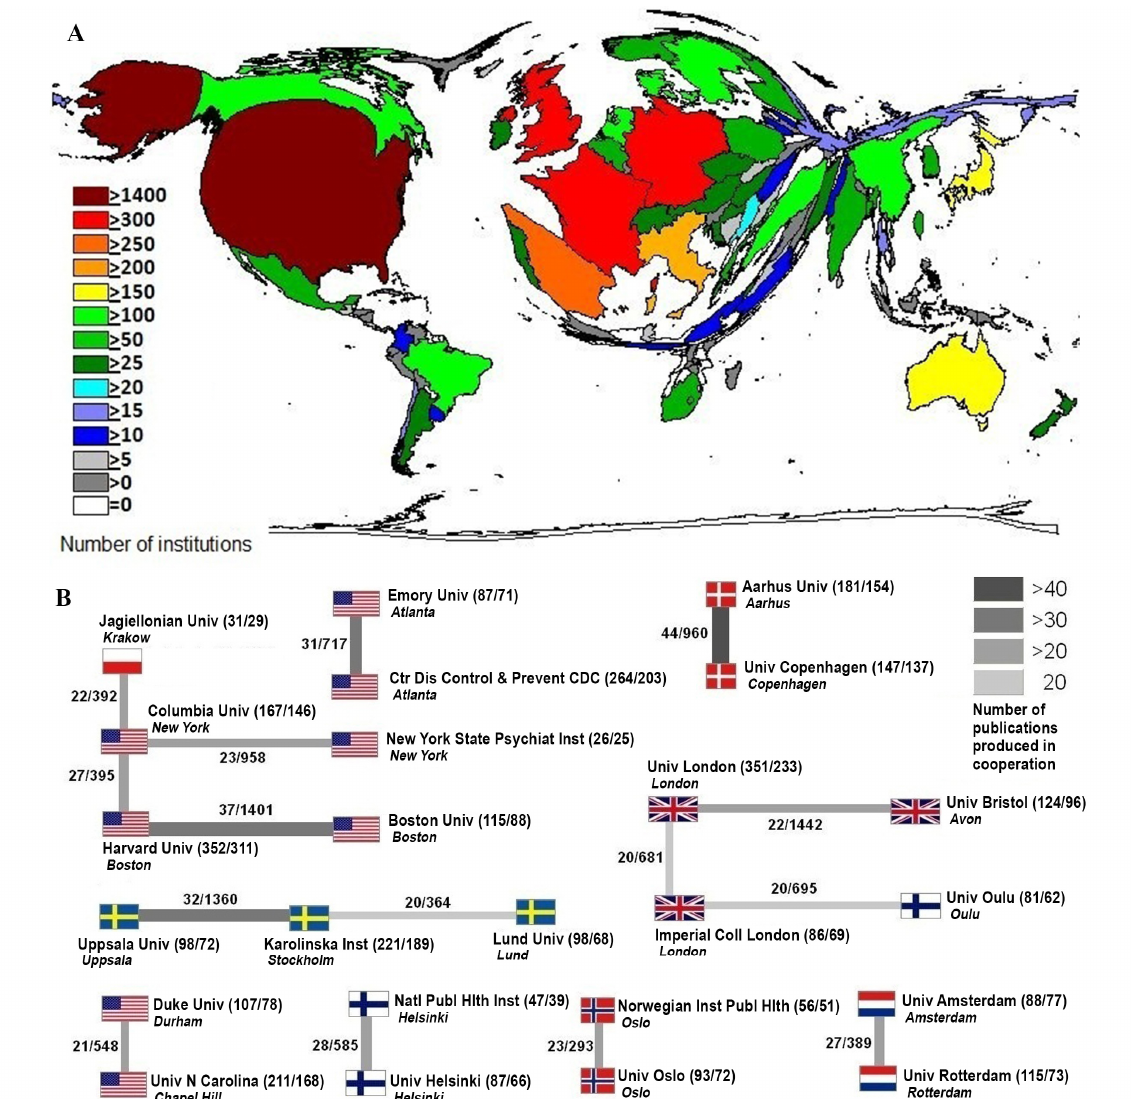
Figure 6. Institution analyses. ( A ) National institution volume; ( B ) Cooperation of